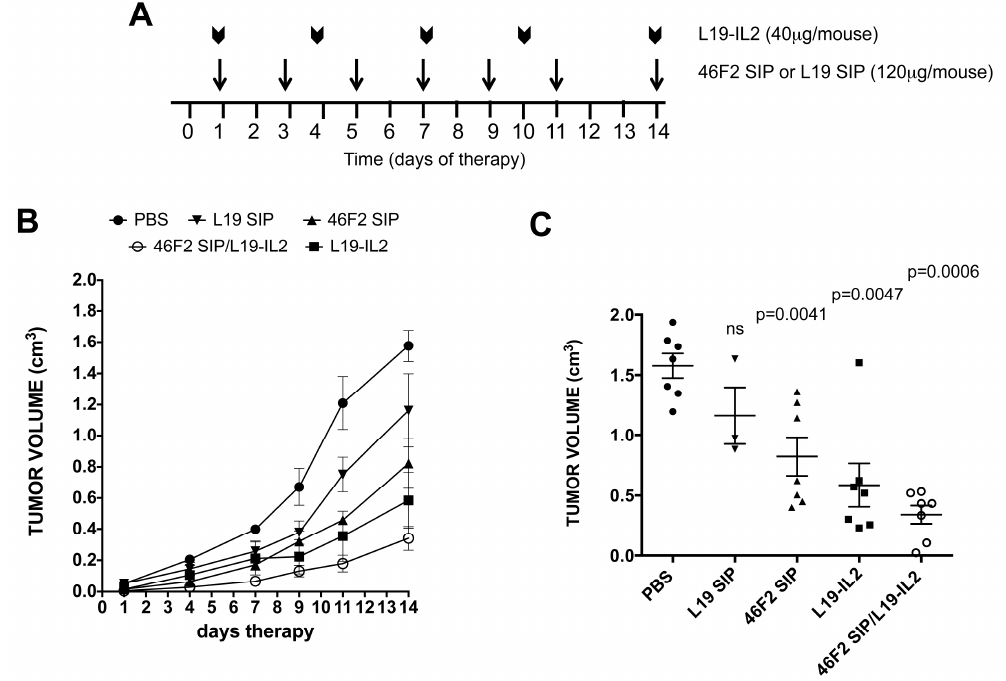
Figure 5. Therapeutic efficacy of 46F2SIP in combination therapy with L19-IL2 in a SKOV3 ovarian